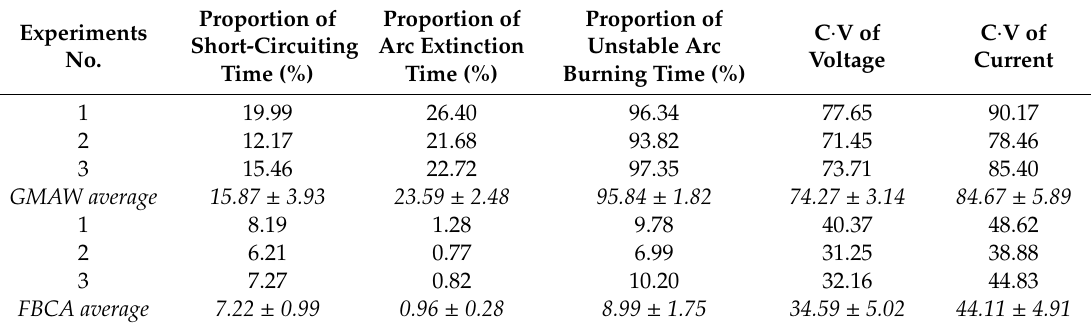
Table 3. Analysis results of arc